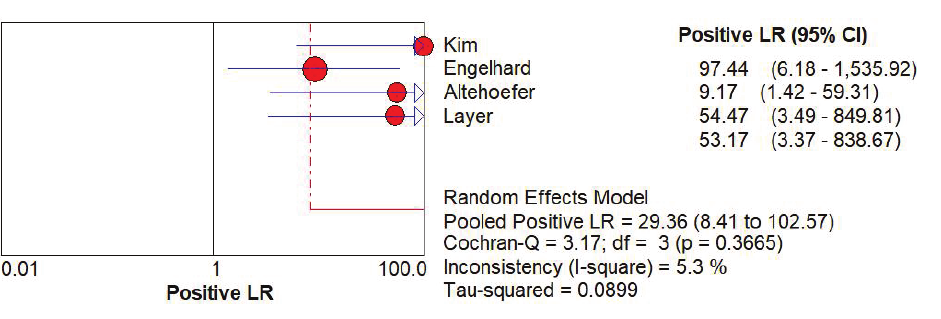
Figure 6: The plot for the negative LR of MRI